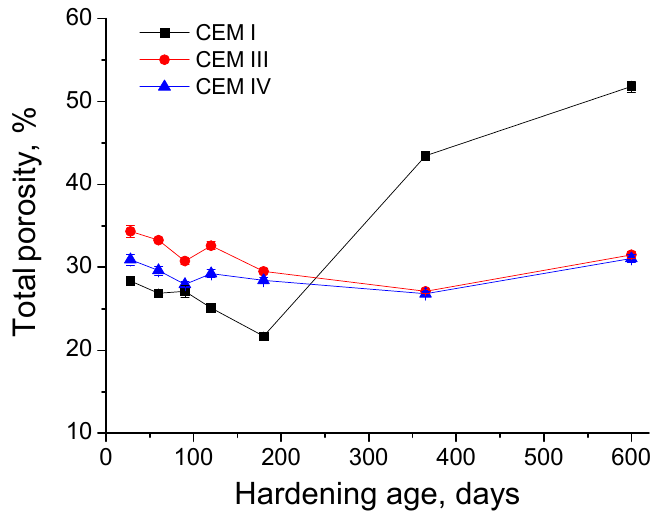
Figure 7. Total porosity results for CEM I, CEM III and CEM IV grouts.